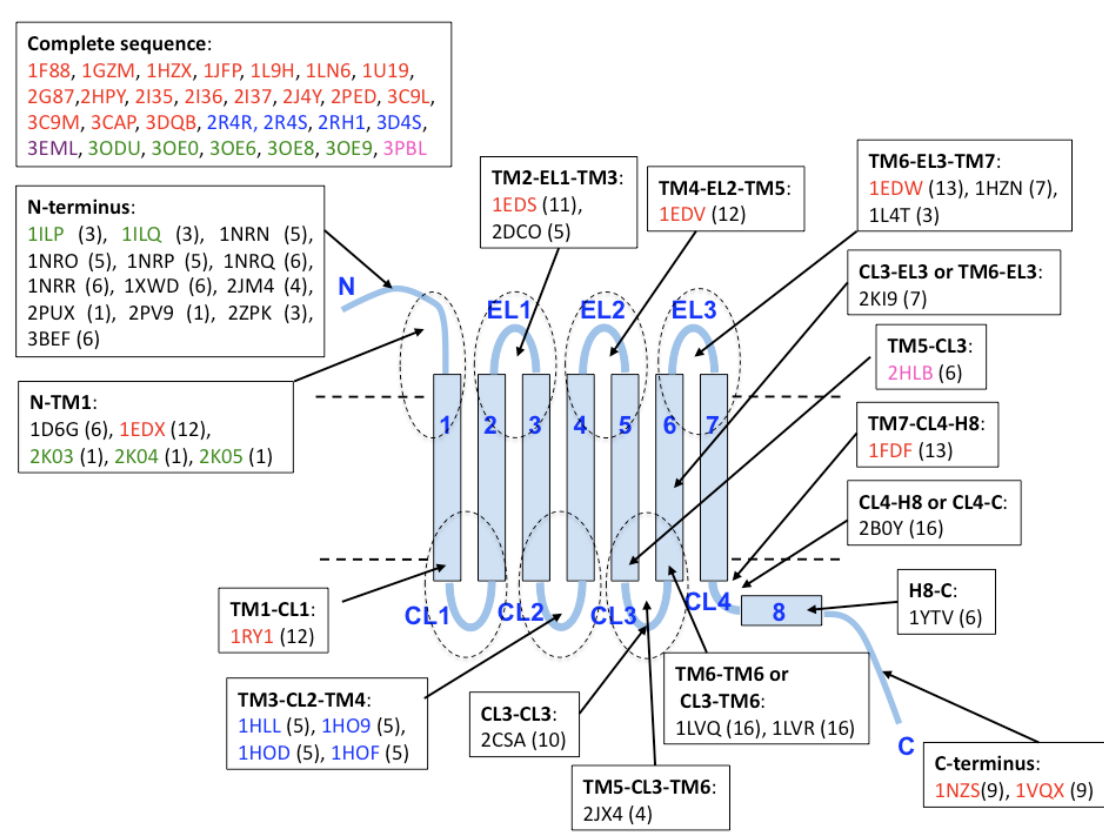
Figure 4. Schematic representation of PDB data that are annotated to Class A type entry sequences in SEVENS database. The 3D structures of five subfamilies were solved completely: bovine rhodopsin (colored in red), adrenergic receptor (in blue), adenosine receptor (in magenta), chemokine receptor (in green), and dopamine receptor (in pink). Fragments of these receptors are shown in the same color code. Number in parenthesis represents the hit count of PDB regions to the sequences identified in SEVENS